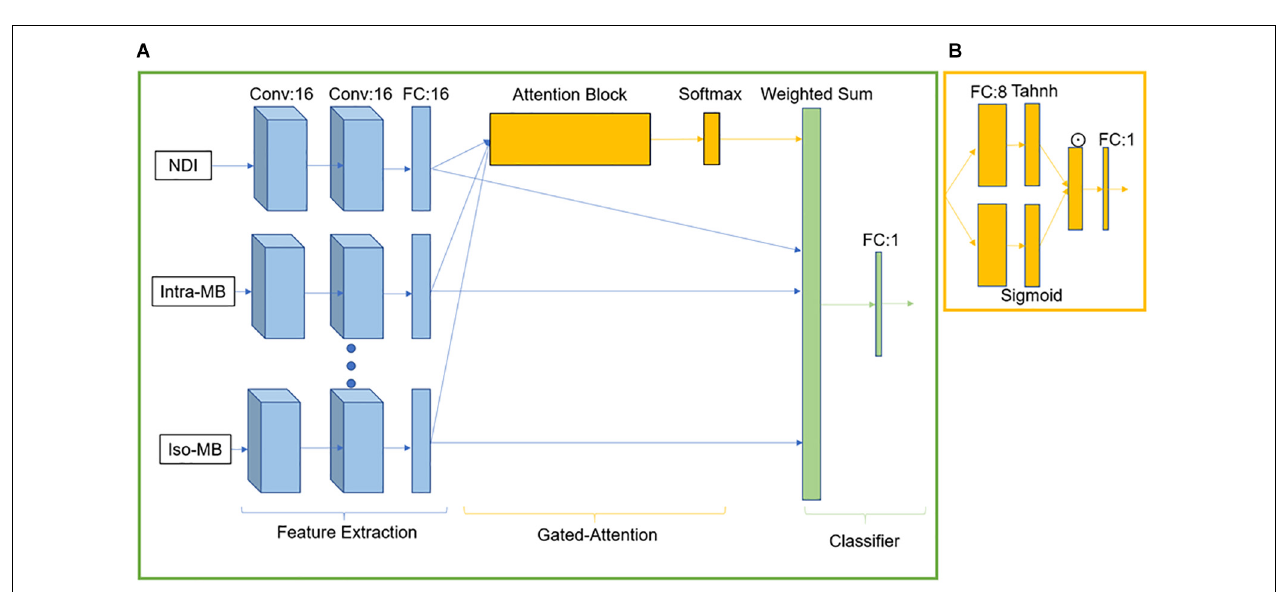
FIGURE 1 | MS lesions on FLAIR and diffusion measures. (A) FLAIR: MS lesions are hyperintense and indicated by red dashed boxes. (B) Red: lesions; Green: perilesional white matter tissue. (C) The isotropic compartment from MB. (D) The intra-axonal compartment from MB. (E) The neurite density index from NODDI. (F) The intra-axonal compartment from SMT-NODDI. (G) The intra-axonal compartment from MCMDI. (H) The intra-axonal compartment from NODDIDA. (I) The isotropic compartment from Ball and Stick. (J) The intra-axonal compartment from Ball and Stick. Other measures in the analysis are in Supplementary Figure 1 .